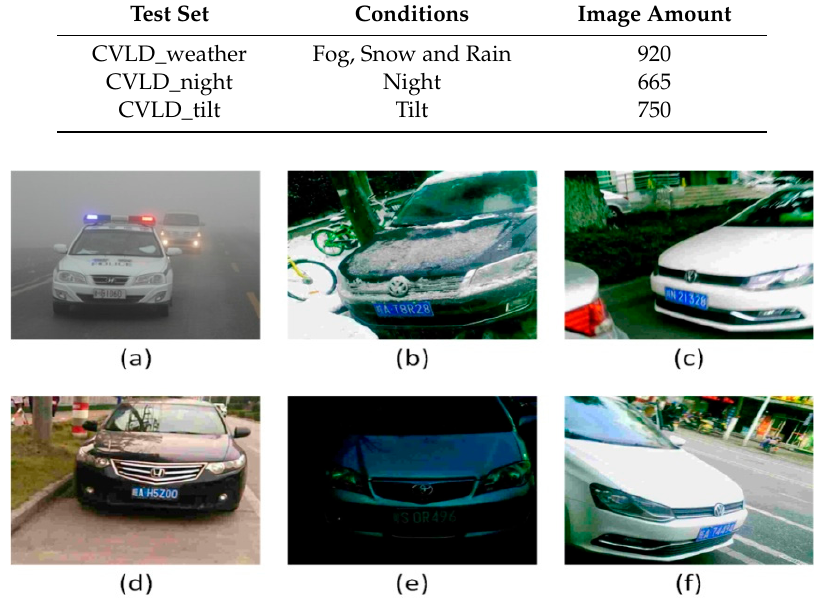
Figure 9. Some example in CVLD dataset: ( a ) fog ( b ) snow ( c ) rain ( d ) day ( e ) night ( f ) tilt.